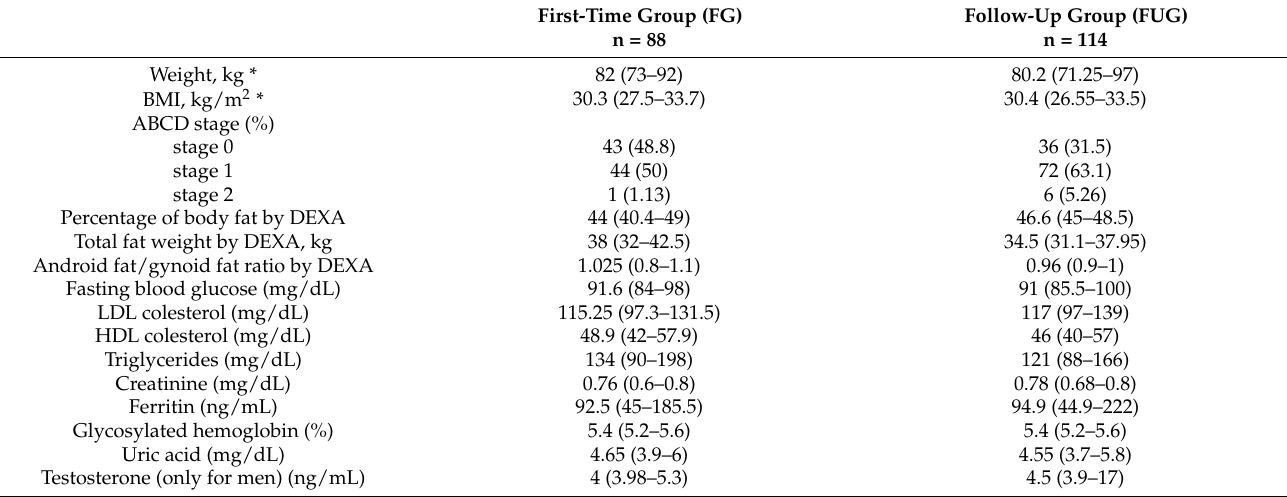
Table 2. Clinical characteristics at the first teleconsultation by type of